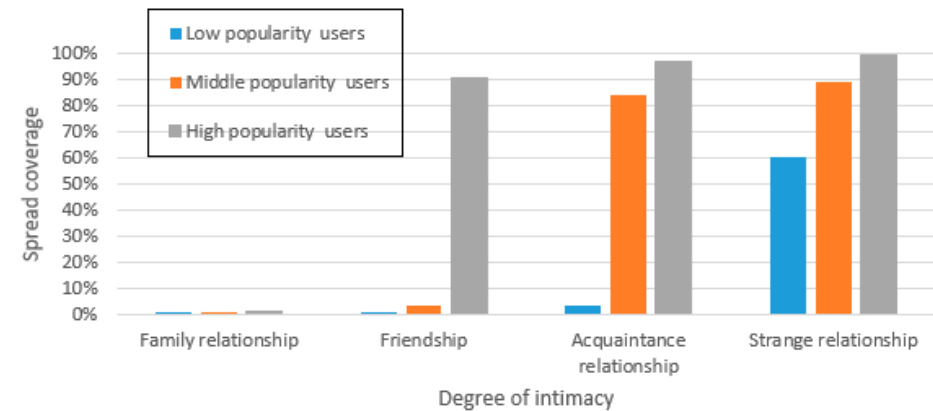
Figure 4. Range of privacy dissemination vs. intimacy and popularity.